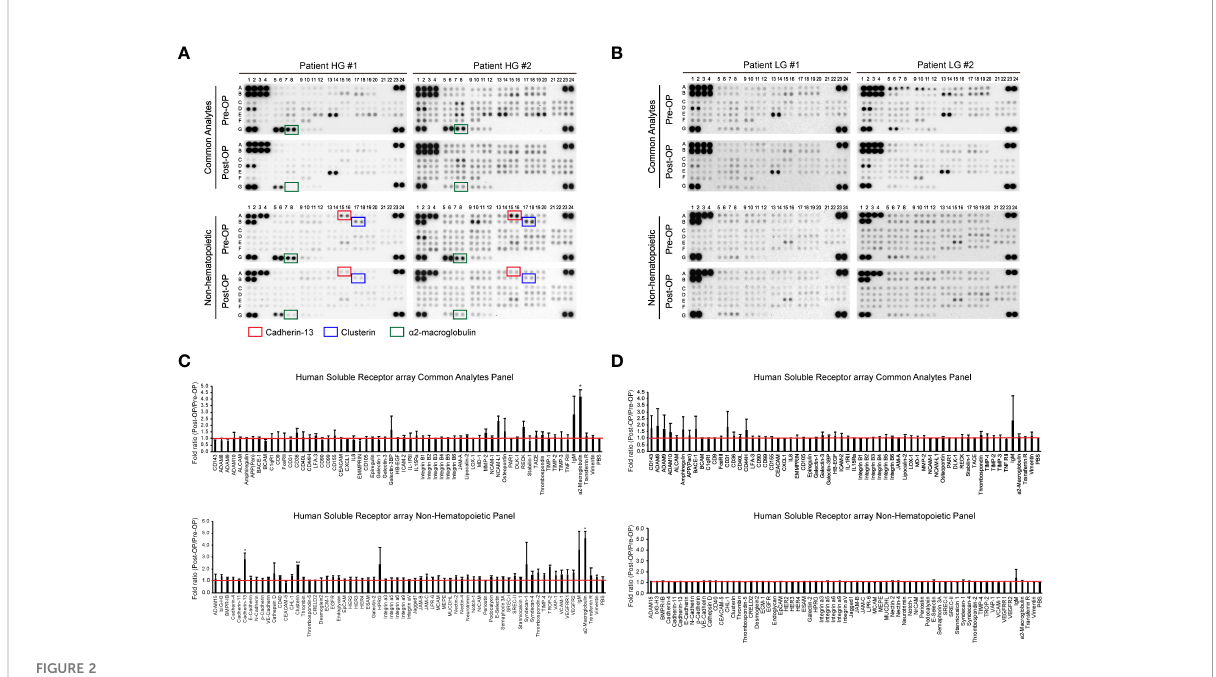
FIGURE 2 Screening of bladder cancer-associated EV proteins. Urine was collected from bladder cancer patients on the day before surgical intervention (Pre-OP) and at follow-up three months after surgery (Post-OP). EVs were separated from the collected urine using ExoDisc. After protein quanti fi cation with the micro BCA assay, 5 µg of EVs was subjected to a Proteome Pro fi ler array for human soluble receptors. (A, B) Results from the protein array analysis of urinary EVs from high-grade bladder cancer patients (A) and low-grade bladder cancer patients (B) . Pre-OP and Post-OP: EVs from a pre- or post-operative bladder cancer patient urine. HG and LG: urinary EVs from high-grade (HG) or low-grade (LG) bladder cancer patients. Red, blue, and green boxes indicate cadherin-13, clusterin, and a2M, respectively. (C, D) Data analysis of antibody array results with urinary EVs from high-grade (C) or low-grade (D) bladder cancer patients. The fold ratio for the signal value of each protein (Pre- OP/Post-OP) is presented on the Y-axis. PBS was used as a negative control, and the calculated value for PBS is indicated by a red line. Data are presented as the mean ± SD, n = 2,